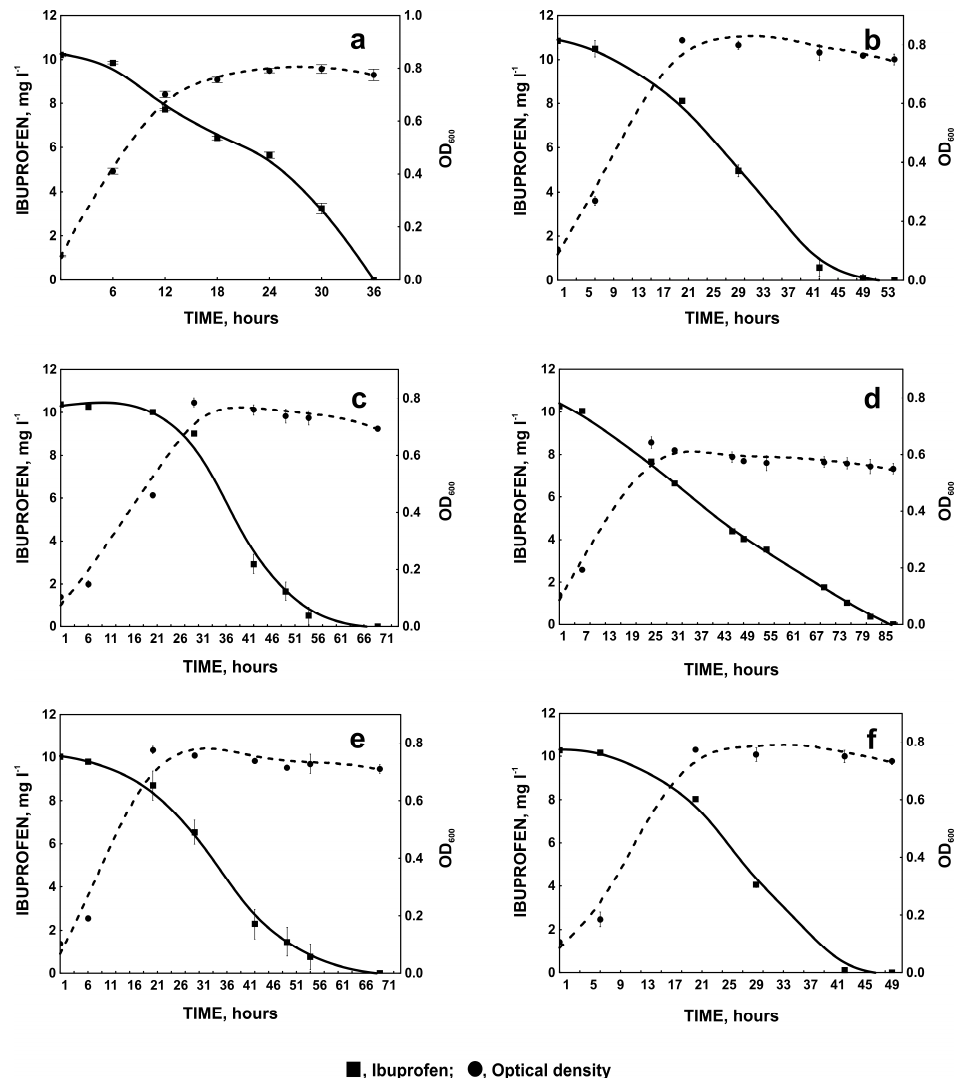
Figure 4. Biodegradation of ibuprofen by Bacillus thuringiensis B1(2015b) and changes in optical density of the control culture ( a ) and in the presence of metal ions: Cu(II) ( b ), Cd(II) ( c ), Co(II) ( d ), Cr(VI) ( e ), or Hg(II) ( f ). The data points represent the average of three independent experiments. Low NOEC values for Cd(II) and Cu(II) (Table 1) indicate high sensitivity of Bacillus thuringiensis